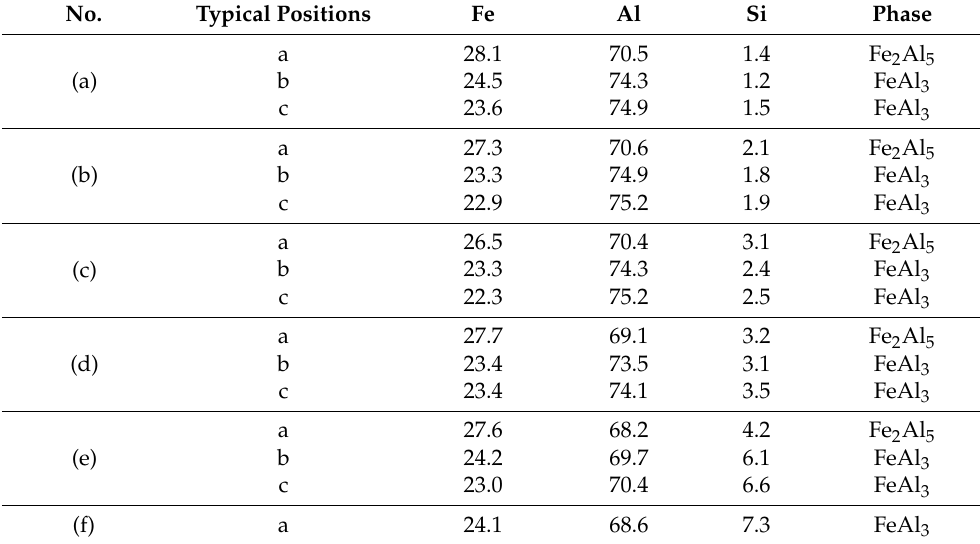
Figure 4. Relationship between intermetallic thickness of Q345 steel after hot-dip aluminum with different silicon content.